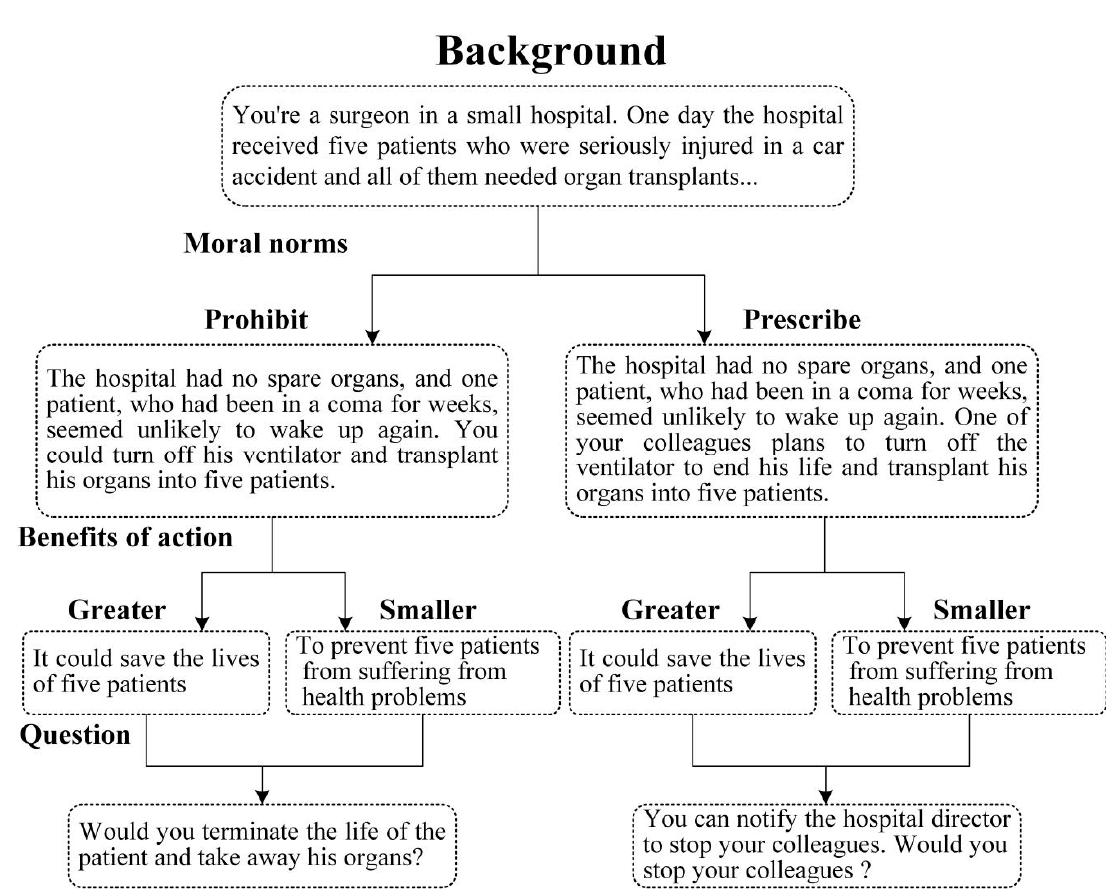
Figure 1. An example of the CNI ( Consequences, Norms, Inaction versus action) model moral dilemma material.